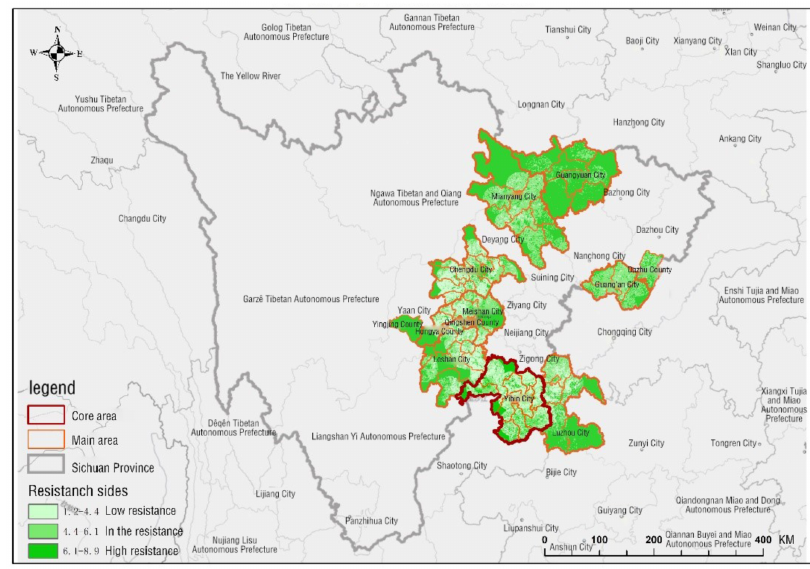
Figure 23. Analysis of resistance sides of research areas in Sichuan Province.